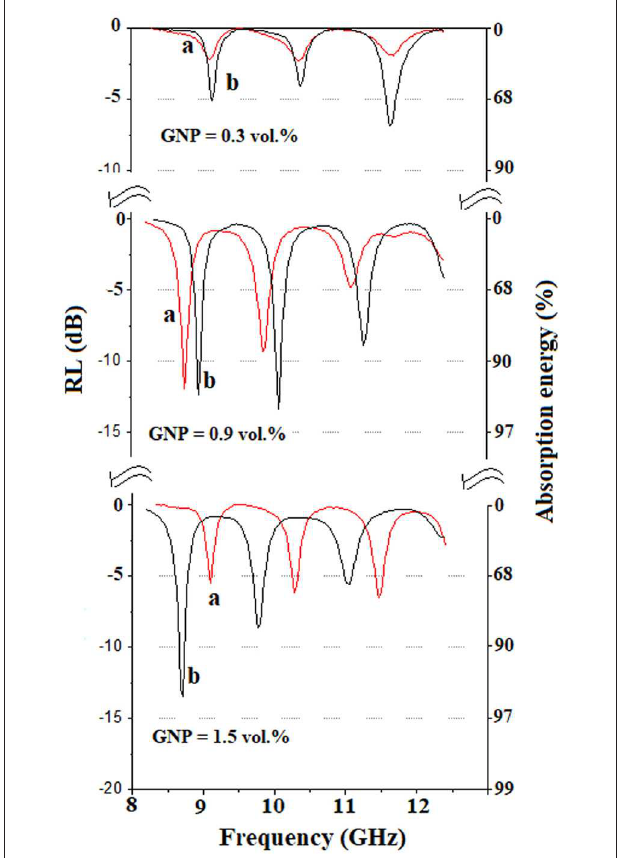
FIGURE 5 | Reflection loss in the X-band frequency range for the ER/GNP composites with thickness of 2mm (a; red line) = GNP; (b; black line) =